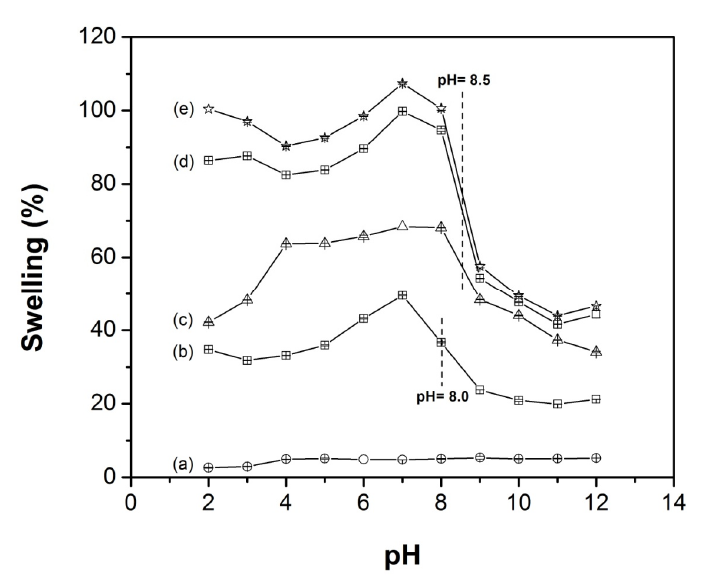
Figure 9. Dependence of swelling degree with respect to pH for SR-g-(NVCL-co-NVIM) at different grafting yield: 7.5% graft ( a ), 24% graft ( b ), 50% graft ( c ), 52% graft ( d ), and 59% graft ( e